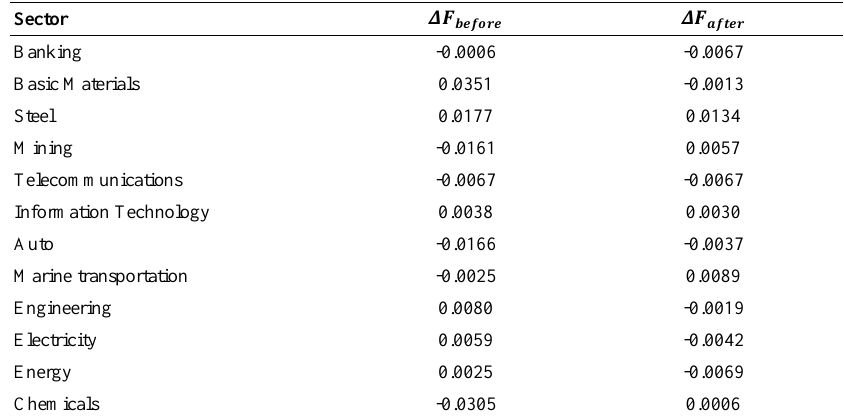
Table 14. The net information outflow for the sectors in TSE market, before and after COVID-19 outbreak – evaluated through the symbolic coding scheme of Equation 8